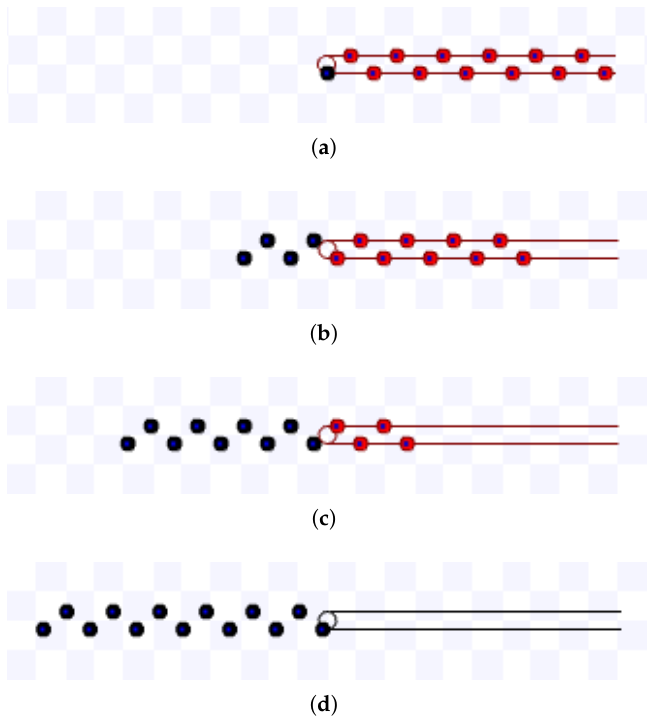
Figure 20. Simulation on Stage for compact lanes strategy using s = 0.3 m, d = 1 m during T = 7.1 s. Available on https://youtu.be/e1cWJzWhQmQ, accessed on 12 June 2022. ( a ) 0 s: beginning of the simulation; ( b ) After 2.7 s; ( c ) After 6.7 s; ( d ) 5 s: ending of the simulation.